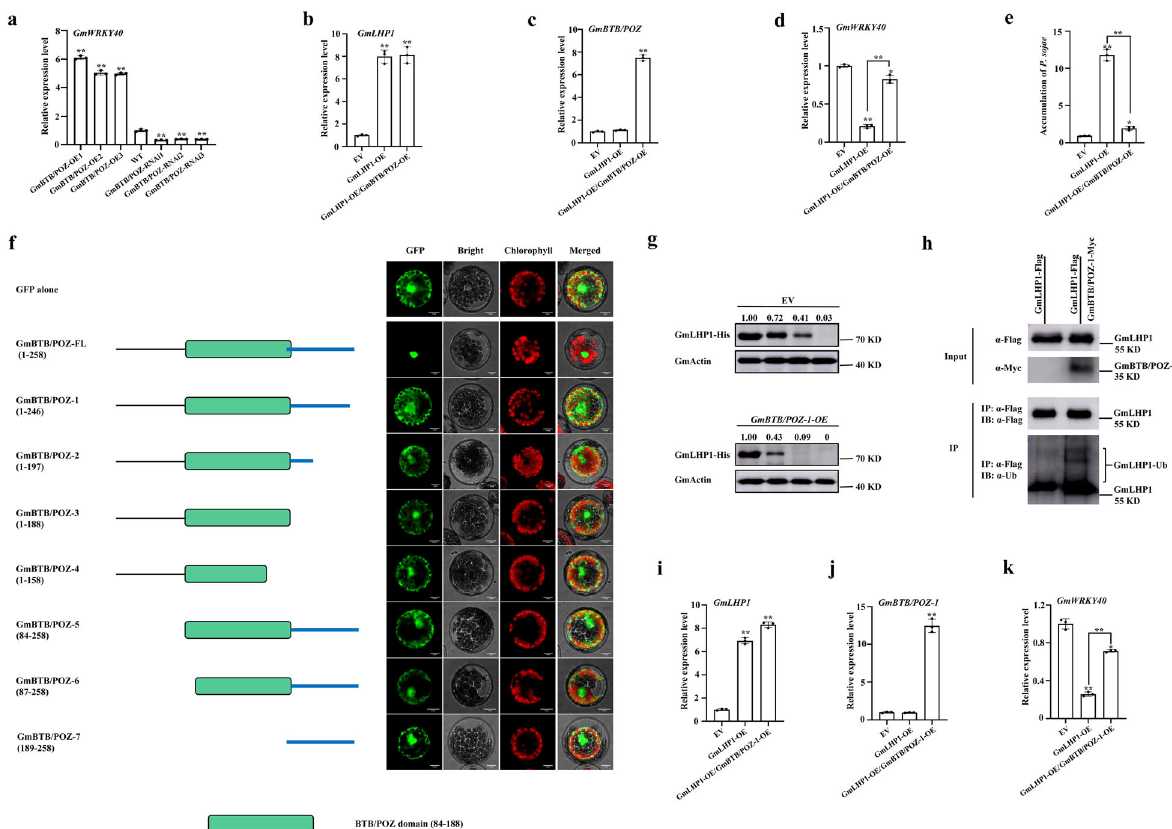
Fig. 7 GmBTB/POZ weakens GmLHP1-mediated suppression of GmWRKY40 and increases GmLHP1-regulated responses to P. sojae . a GmWRKY40 transcript levels in GmBTB/POZ-OE and GmBTB/POZ-RNAi soybean plants. b GmLHP1 transcript levels in EV, GmLHP1-OE , and GmBTB/POZ-OE/GmLHP1-OE transgenic soybean hairy roots. c GmBTB/POZ transcript levels in EV, GmLHP1-OE , and GmBTB/POZ-OE/GmLHP1-OE transgenic hairy roots. d GmWRKY40 transcript levels in EV, GmLHP1-OE , and GmBTB/POZ-OE/GmLHP1-OE transgenic hairy roots. e Relative biomass of P. sojae in EV, GmLHP1-OE , and GmBTB/ POZ-OE/GmLHP1-OE transgenic hairy roots based on the transcript level of P. sojae TEF1 (EU079791) after 48 h of P. sojae inoculation. f Subcellular localization of various GmBTB/POZ deletion mutants. Left column, scheme of GmBTB/POZ and its deletion mutants fused to GFP. FL, full length. Right column, the indicated constructs were transiently expressed in Arabidopsis protoplasts and inspected with a confocal microscope. Scale bars indicate 10 µ m. g In vitro cell-free degradation assays of GmLHP1-His in protein extracts from GmBTB/POZ-1-OE soybean hairy roots. h GmBTB/POZ-1 promotes the ubiquitination of GmLHP1 in vivo. GmLHP1-Flag was immunoprecipitated using anti-Flag-Tag Mouse mAb (Agarose Conjugated) from GmLHP1-OE and GmLHP1-OE/GmBTB/POZ-1-OE soybean hairy roots by high-ef fi ciency A. rhizogenes -mediated transformation. The transgenic hairy roots were treated with 100 µ M MG132 for 8 h before extraction. The immunoprecipitated protein was examined using anti-Flag and anti-ubi antibodies. i GmLHP1 transcript levels in EV, GmLHP1-OE , and GmLHP1-OE/GmBTB/POZ-1-OE transgenic soybean hairy roots. j GmBTB/POZ transcript levels in EV, GmLHP1-OE , and GmLHP1-OE/ GmBTB/POZ-1-OE transgenic hairy roots. k GmWRKY40 transcript levels in EV, GmLHP1-OE , and GmLHP1-OE/GmBTB/POZ-1-OE transgenic hairy roots.